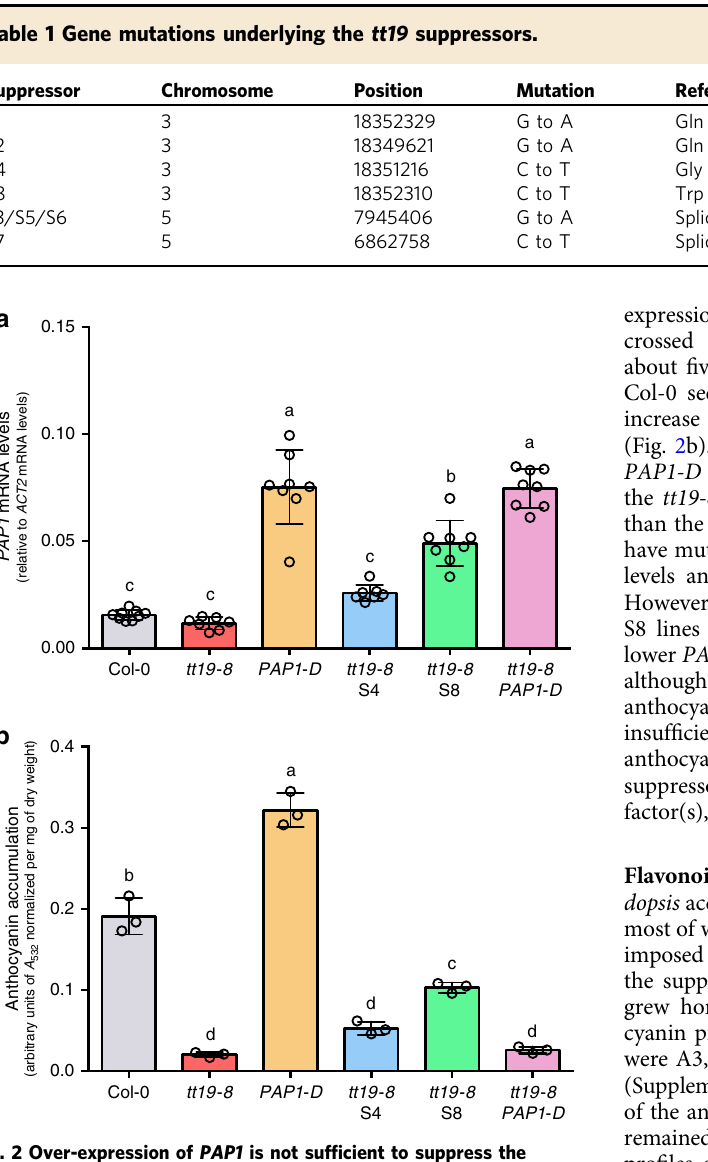
Fig. 1 Molecular characterization of the tt19-8 phenotypic suppressors S1-S8 and corresponding anthocyanin accumulation. a Structure of the RDR6 gene indicating the position and nature of the EMS-induced mutations for the S1, S8, S4, and S2 suppressors. The images show 4-day-old seedlings grown in AIC and accumulating various levels of anthocyanins evaluated by absorbance at 532 nm (A 532 ), and normalized to the dry weight of the seedlings. The levels present in Col-0 were taken as 100%. b Structure of the SGS3 gene indicating the mutations for the S3, S5, and S6 suppressors. All three suppressors showed similar levels of anthocyanins in AIC and the same mutation, which abolishes a splicing acceptor site. The genome browser image on the top right shows the reads obtained in RNA-seq experiments for S5, and the region demonstrating the use of an alternate splicing acceptor site in the S5 mutant is shown expanded on the lower image. c Structure of the DCL4 gene indicating the mutation for the S7 suppressor, which abolishes a splicing donor site, as evidenced by the genome browser images comparing the RNA-seq reads of Col-0, tt19-8 , and S7. Similar anthocyanin quanti fi cation results were obtained from at least three independently repeated experiments. Bar, 400 μ m.